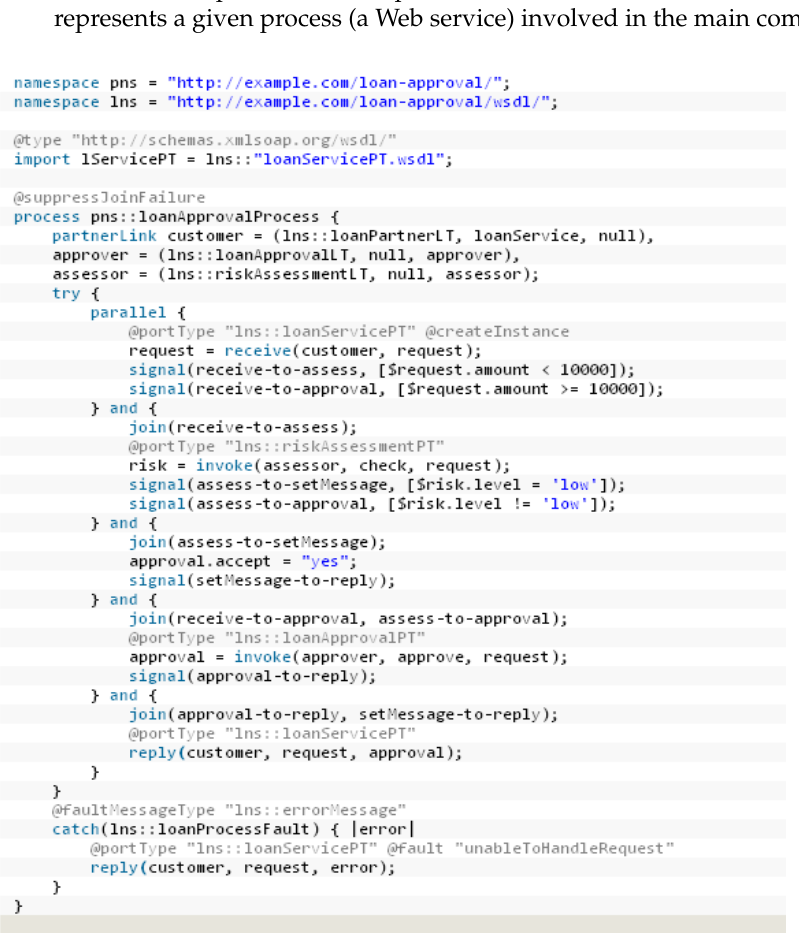
Figure 6. A simple BPEL